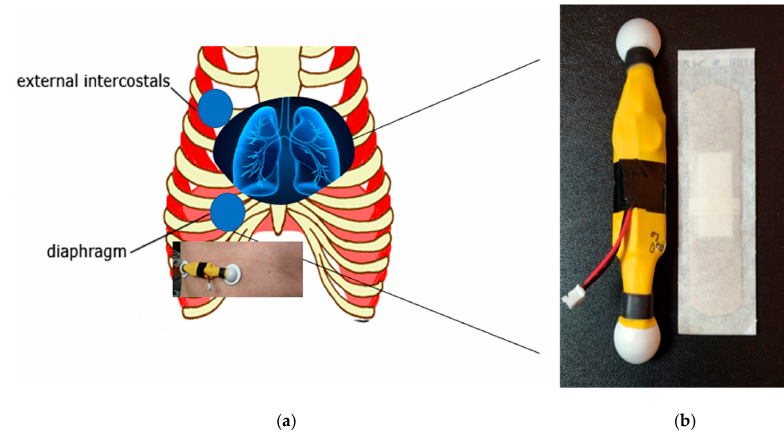
Figure 1. The wireless wearable health sensor: ( a ) Placements of the sensor; ( b ) The external views of the sensor.